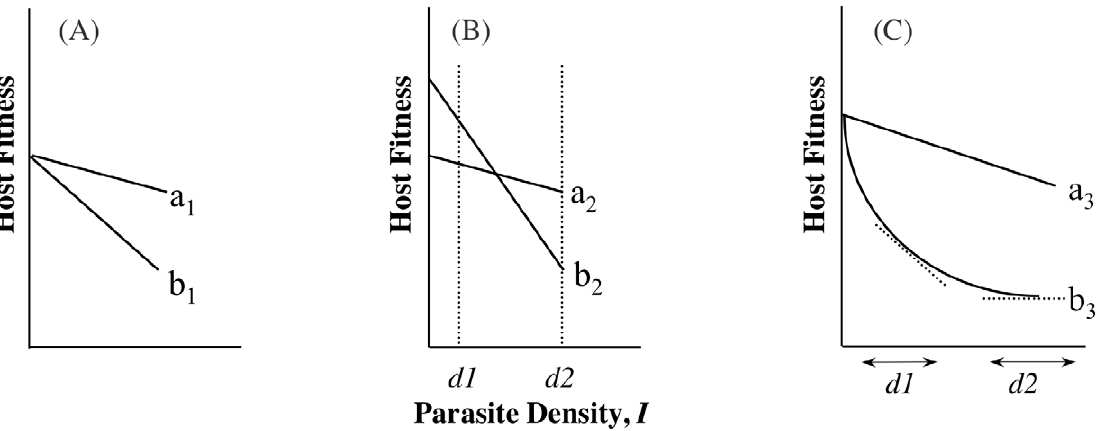
Figure 1. The importance of intercepts: point versus range tolerance. To understand differing interpretations of the evolutionary consequences of tolerance, it is necessary to consider when point and range tolerance will disagree. Below is one scenario where they will agree, and two where they may not. (A) With fitness in the absence of infection identical, at whichever parasite density measured, the fitness of the genotype with the flatter slope will be higher; here, genotype a 1 is more tolerant than b 1 regardless of how it is assessed. Both point and range tolerance measures therefore agree over the more tolerant genotype. (B) Here genotypes differ for their intercept, and the genotype with the higher point tolerance differs depending on whether parasite density is measured at d1 (where b 2 . a 2 ) or d2 (where a 2 . b 2 ). The fitness at d1 is strongly influenced by fitness in the absence of infection, while fitness at d2 is more strongly influenced by how fitness declines with increasing I . Under range tolerance, however, a 2 is more tolerant, despite the fact that it is less (point) tolerant at low densities. (C) Here the point tolerance is always higher for a 3 , but the range tolerance depends upon the range of I considered; if tolerance is measured across the range depicted by d1 , genotype